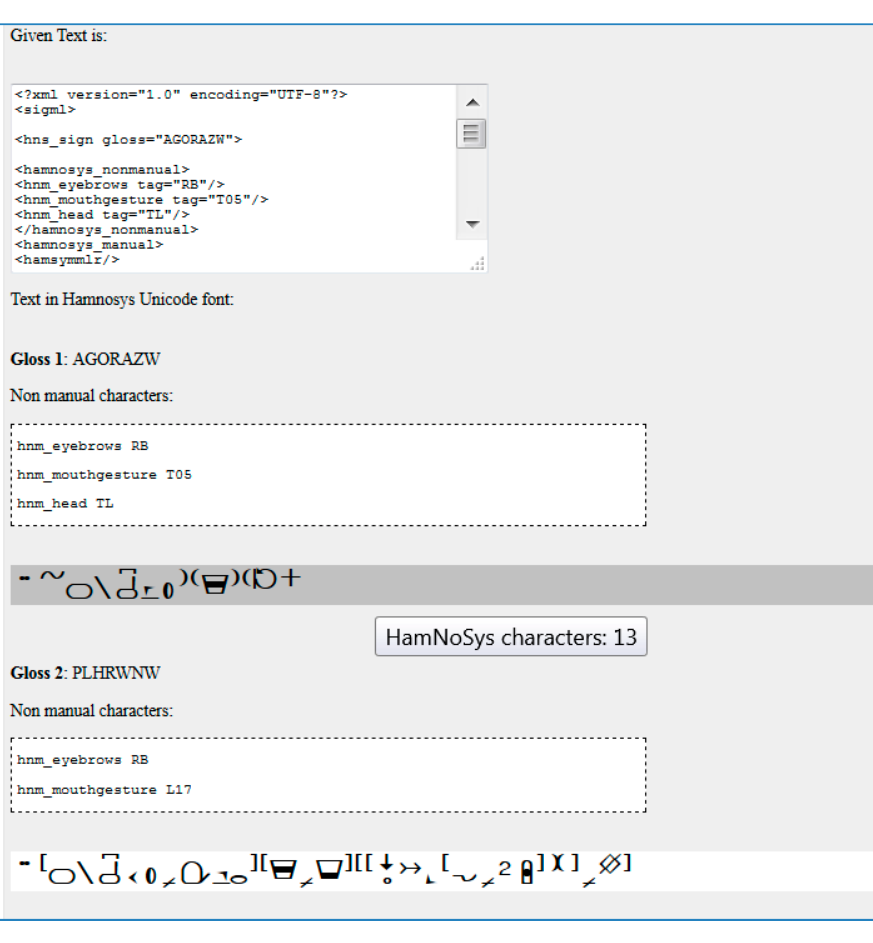
Figure 7. Converting SiGML to HamNoSys.